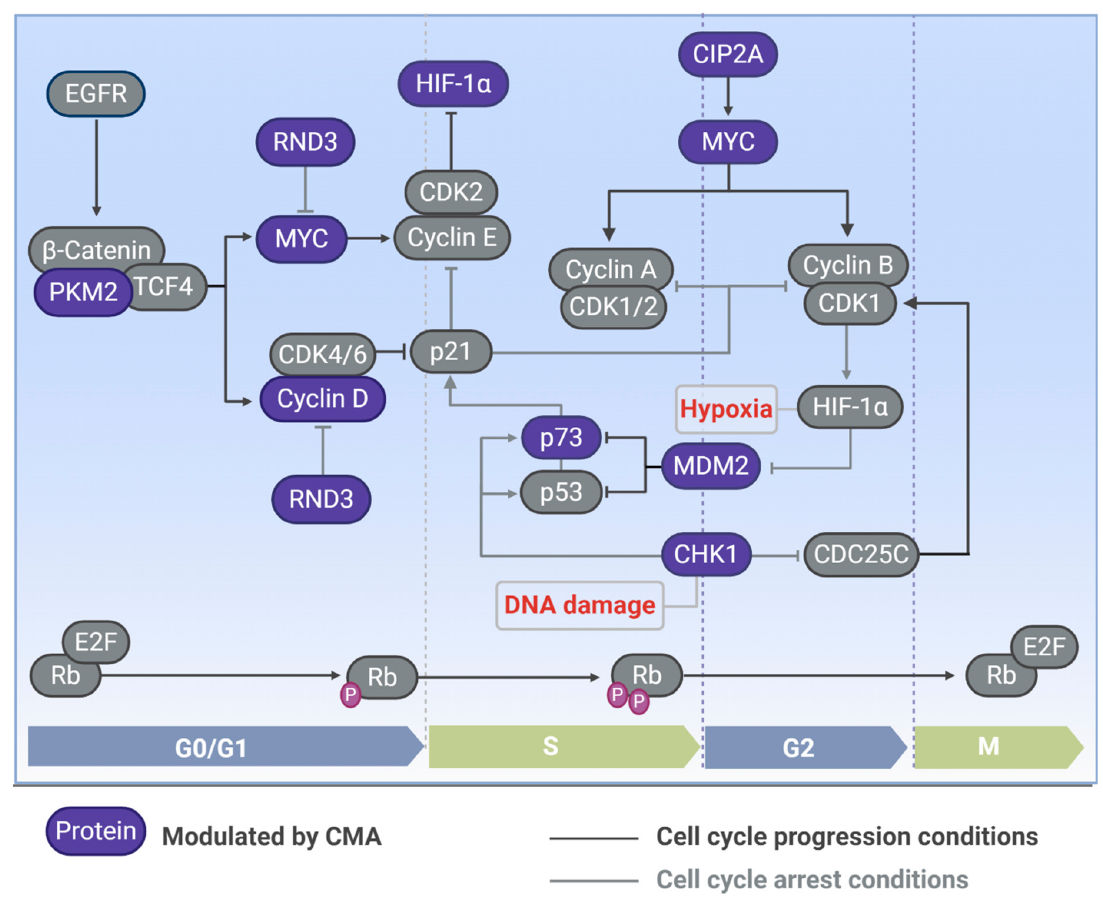
Figure 2. Cell cycle proteins modulated by CMA. CMA modulates the levels of proteins involved in the cell cycle, such as pyruvate kinase (PKM2), which stimulates MYC and cyclin D for cell cycle progression in G1. Cyclin D interacts with cyclin-dependent kinase (CDK) 4/6 and inhibits p21 for cell cycle progression; p21 can also be modulated by Rho family GTPase 3 (RND3), another CMA substrate that induces cell cycle arrest in G1. MYC is also induced through the cancerous inhibitor of protein phosphatase 2A (CIP2A), which is modulated by CMA, and is inhibited by RDN3. MYC is required for positive cell cycle regulation and progression through the cyclin-CDK induction. Checkpoint kinase 1 (Chk1) induces cell cycle arrest in DNA damage conditions, and it is degraded by CMA. Mouse double-minute 2 homolog (MDM2) is a CMA substrate that inhibits p53 and p73 for cell cycle progression; p73 is also controlled by CMA and promotes cell cycle arrest by inducing p21. In hypoxia situations, the hypoxia-inducible factor-1 subunit alpha (HIF-1 α ) is induced by CDK1 and inhibits MDM2 to trigger cell cycle arrest, HIF-1 α can be inhibited by CDK2 for cell cycle progression. Proteins reported to be modulated by CMA are represented in blue. Phases of the cell cycle: G1 (gap 1 phase), S (synthesis phase), G2 (gap 2 phase), M (mitosis phase). Figure created with Biorender.